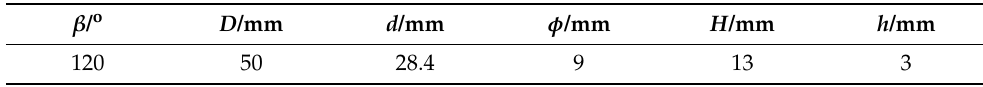
Figure 3. ( a ) The fabricated pot-shaped metal rubber, and ( b ) the dimensions of metal rubber. Table 1. Main characteristics of pot-shaped metal rubber.